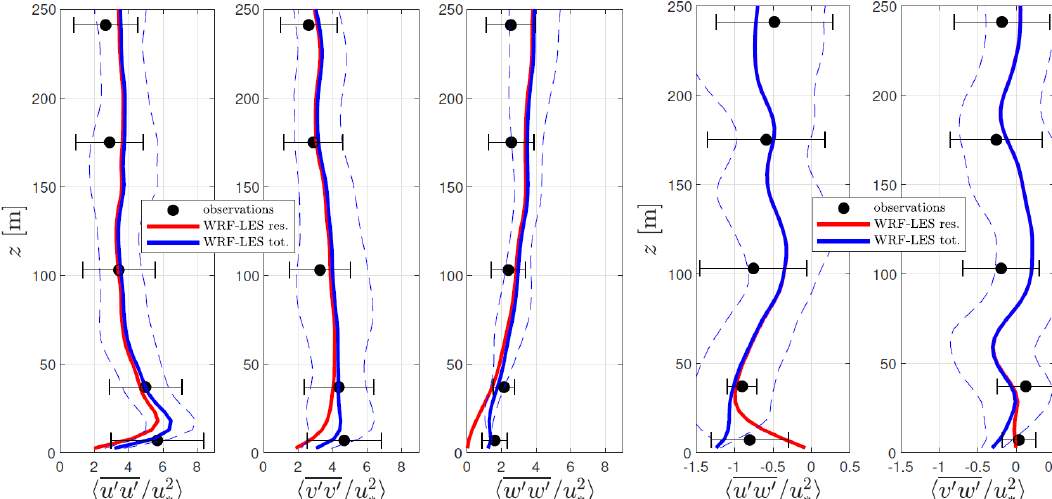
Figure 10. Similar to Fig. 9 but for unstable conditions.